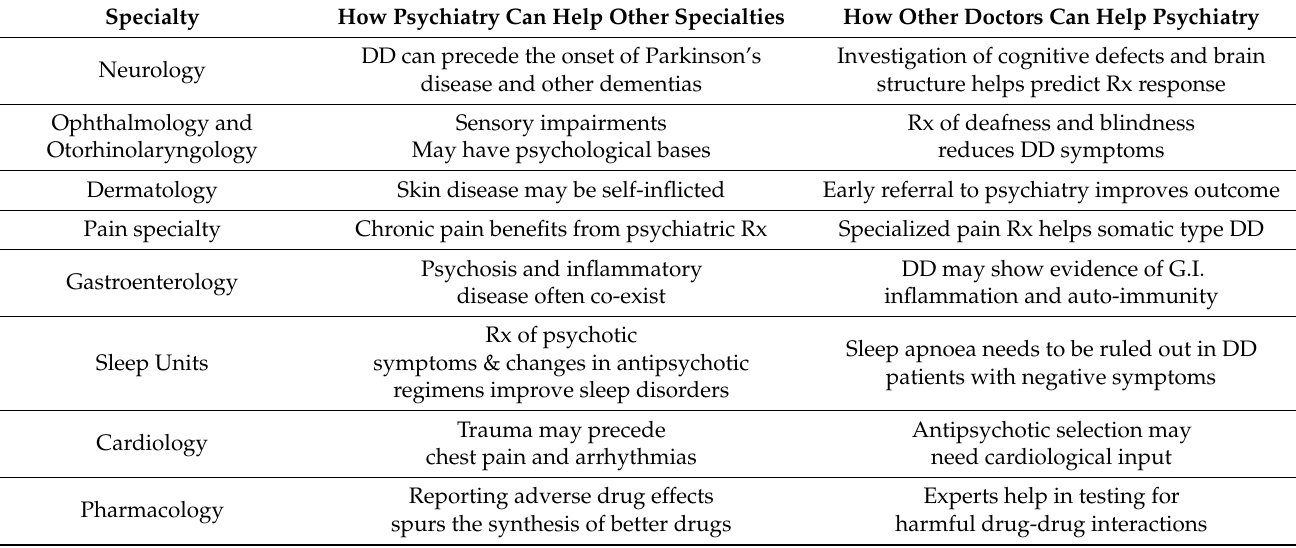
Table 1. Reasons for the importance of close collaboration between psychiatry and other medical